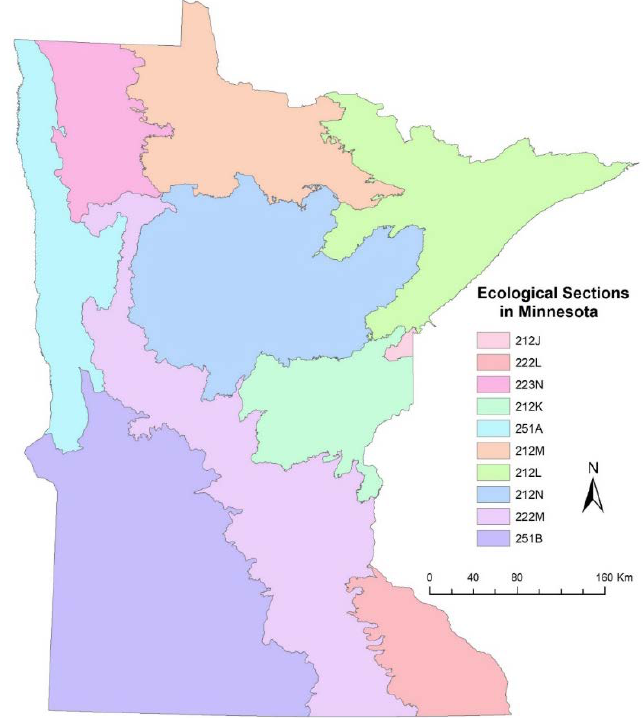
Figure 2. Ecological regions in Minnesota. For the purpose of this study, small ecological regions were combined with a nearby section. Specifically, 212J was merged with 212K, and 251A and 251B were combined with 222M.